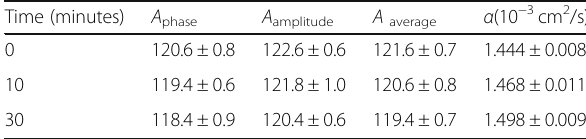
Table 1 Summarized results for thermal properties of Al 2 O